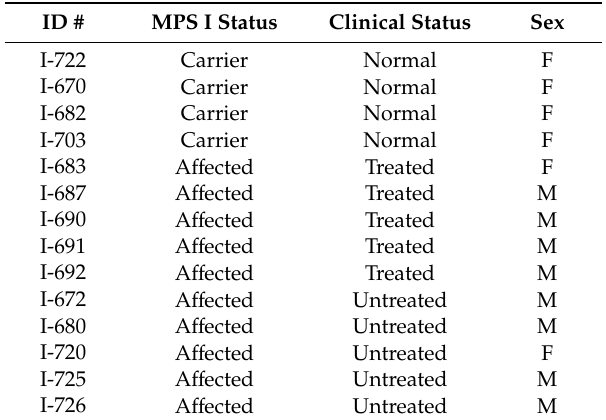
Table 1. Demographics of study population. Identification number, mucopolysaccharidosis I (MPS I) status, clinical status, and sex (all dogs